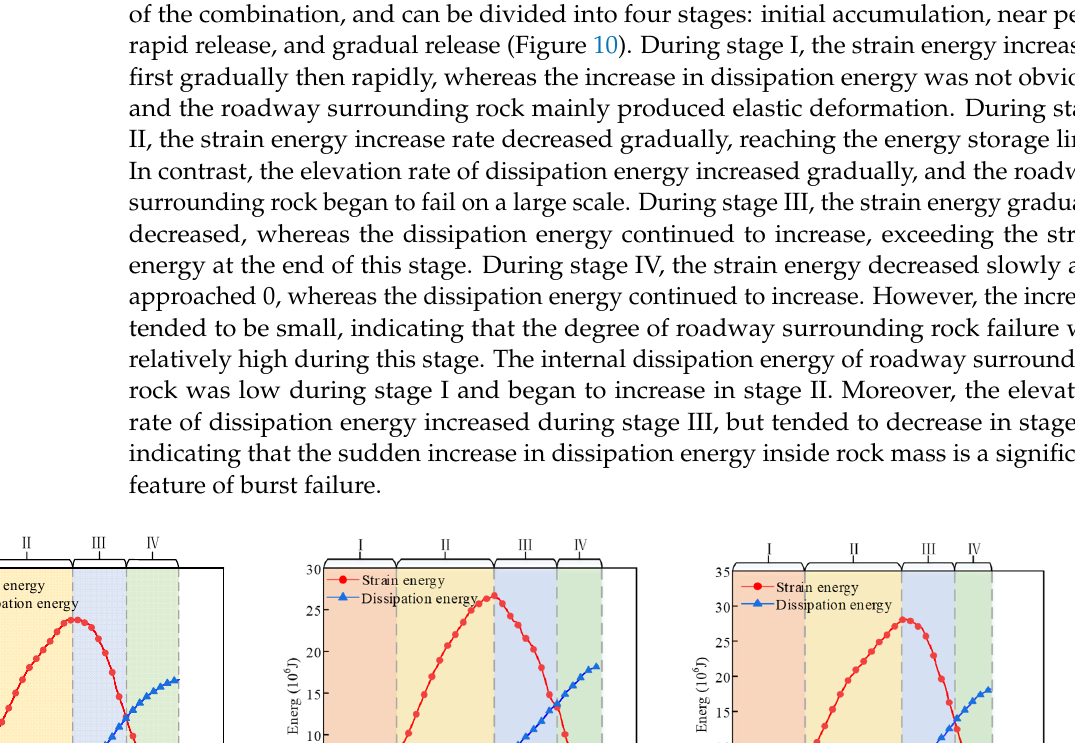
Figure 11. Partition strain energy evolution law of roadway surrounding rock. ( a ) RSR-1; ( b ) RSR- 2; ( c ) RSR-3. The higher the roof-1 strength, the lower the strain energy accumulation in roof-1 (Figure 11a–c). When the strength of roof-1 approached that of roof-2, only a slight differ- ence was present in strain energy between roof-1 and roof-2; as roof-1 strength increased, strain energy accumulation in the coal mass increased. When the roof-1 strength increased from 26.17 to 69.66 MPa, strain energy accumulation in the coal mass increased from 1.14 × 10 7 to 1.37 × 10 7 J. This result suggested that coal mass was the main strain energy accu- mulation area in the roadway surrounding rock system. The hard roof also accumulated a low amount of strain energy; the higher the roof strength, the lower the strain energy accumulation. In addition, the hard roof can improve the energy storage limit of coal mass; the greater the roof strength, the more strain energy accumulated in the coal mass. The strain energy of both shallow and deep coal mass initially increased and then decreased (Figure 12). Before the strain energy accumulated in the shallow coal mass peaked, the strain energy elevation rate of the deep coal mass was the same as that of the shallow coal mass. After the strain energy accumulated in the shallow coal mass peaked, the strain energy accumulated in deep coal mass continued to increase and then decreased until reaching the peak value. It was observed that the strain energy accumulated in the shallow coal mass reached its peak value first; however, it was obviously lower than